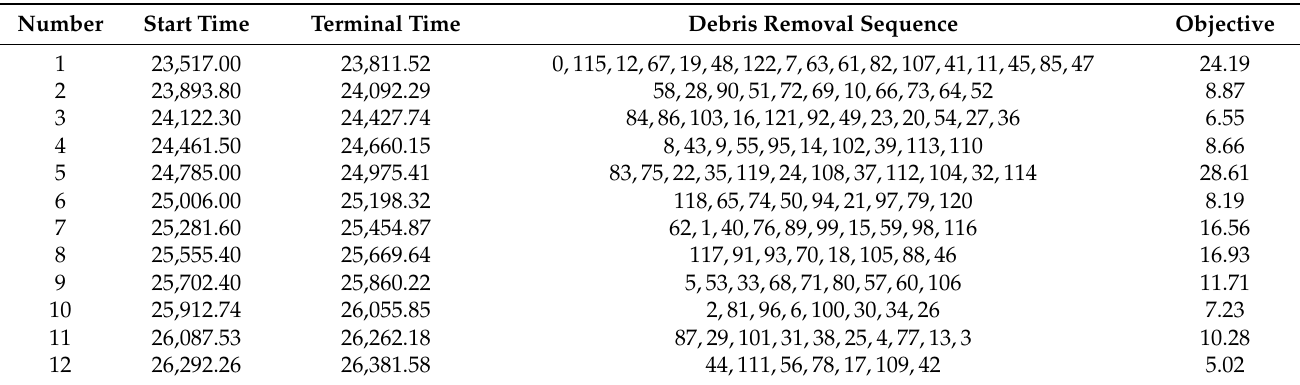
Table 10. Twelve removal sequences for the 123